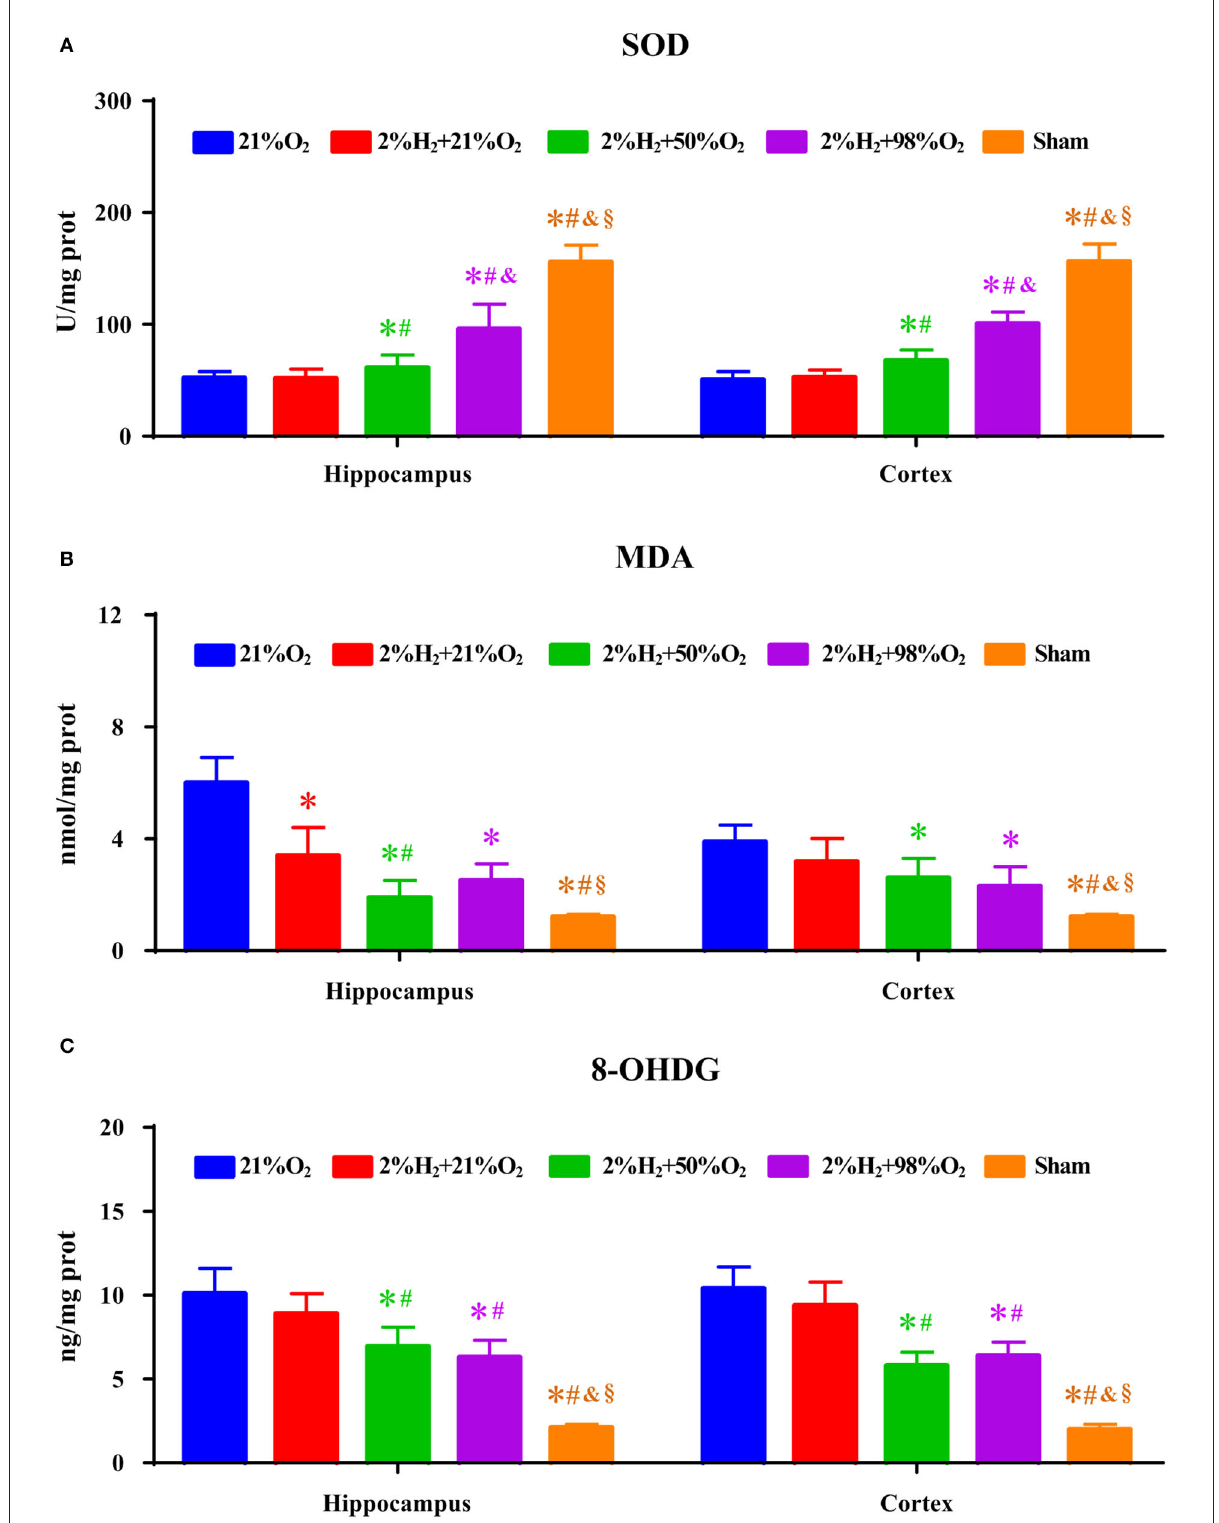
FIGURE3 The concentrations of (A) superoxide dismutase (SOD), (B) malondialdehyde (MDA), and (C) 8-hydroxy-2-deoxy guanosine (8-OHDG) of the hippocampus and cortex were measured 6h after resuscitation in animals under normothermia. * p < 0.05 vs. 21%O 2 group; # p < 0.05 vs. 2%H 2 + 21%O 2 group; & p < 0.05 vs. 2%H 2 + 50%O 2 group; § p < 0.05 vs. 2%H 2 + 98%O 2